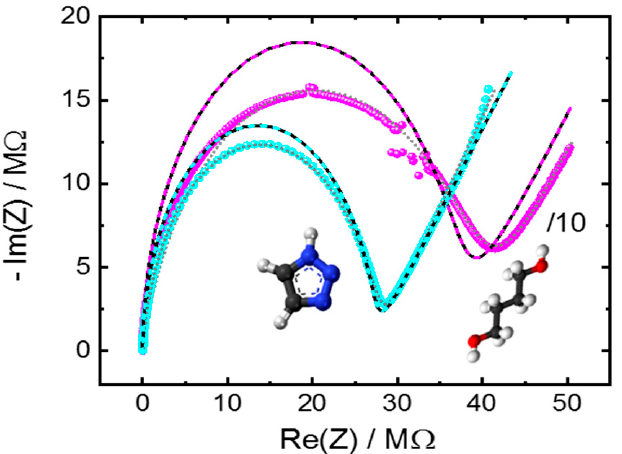
Figure A4. Nyquist plots of the proton-conduction of triazole (cyan) and butanediol (magenta) in a pillared-layered SURMOF on an IDE-substrate—see Figure 4. The experimental data are shown as spheres, the grey-dotted lines are the fits with the ( R-CPE dl ) ‖ CPE geo circuit (same data as in Figure 4). The black-color-dashed lines are the best fits by Randles equivalent circuit. The frequency range is from 0.5 Hz to 5 MHz.